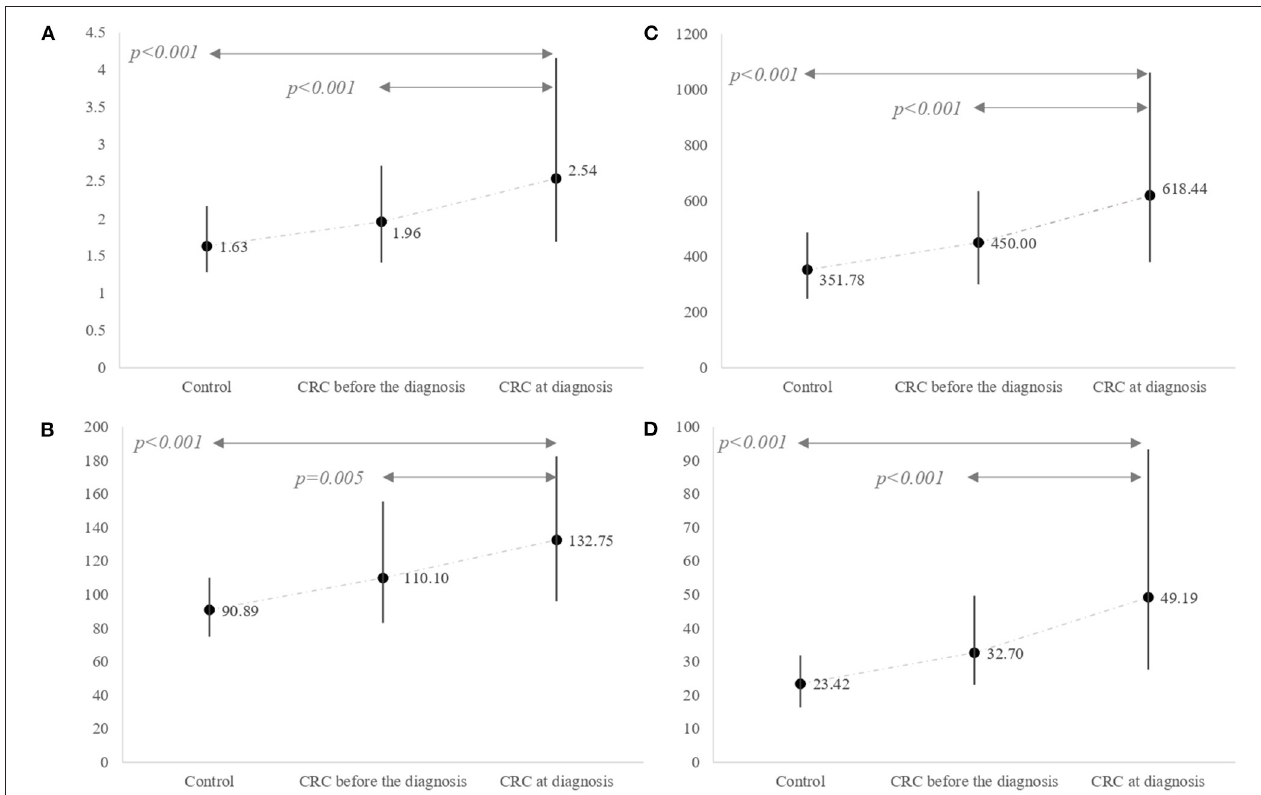
FIGURE 1 | Differences in inflammatory marker levels between the control group and the CRC group. The CRC group was classified according to two different period times. One refers to markers estimated based on blood tests performed several months (median 6 months, IQR 4–8) before the CRC diagnosis and the other one at the diagnosis index time. (A) NLR (median and IQR); (B) PLR (median and IQR); (C) SII (median and IQR); (D) NP/LHb (median and IQR). NLR, neutrophil-to-lymphocyte ratio; PLR, platelet-to-lymphocyte ratio; SII, systemic immune-inflammation index; NP/LHb, neutrophils x platelets/lymphocytes x hemoglobin ratio.